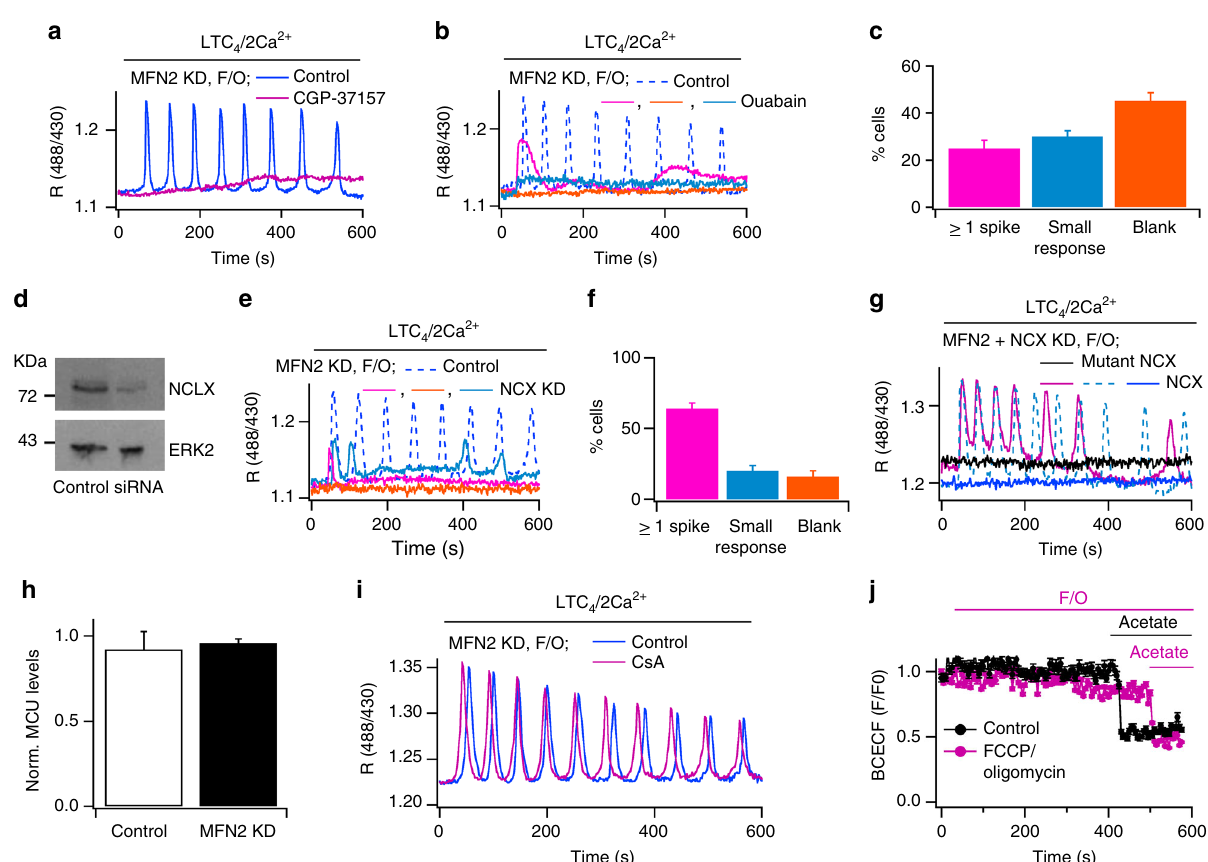
Fig. 2 Oscillations in matrix Ca 2+ by mitochondrial Na + – Ca 2+ exchange. In panels a – f , mitofusin 2 was knocked down and cells were pre-treated acutely with FCCP and oligomycin prior to LTC 4 challenge. Matrix Ca 2+ was measured with ratiometric pericam. a Pre-exposure (10 min) to CGP-37157 (10 μ M) abolished matrix Ca 2+ oscillations to LTC 4 (control: blue trace, typical of 21/29 cells; CGP-treated: red trace, typical of 12/12 cells). b As in panel a , but ouabain (25 μ M; 15 min pre-treatment) was used to raise cytosolic Na + . Three types of matrix Ca 2+ response to LTC 4 were now observed; blank/no response (orange), a small slow rise (blue) or at least one spike (magenta). c Bar plot shows the fractional responses, as in panel b . Total number of cells analysed was 24. d Western blot compares Na + – Ca 2+ exchanger expression in control cells and in cells after siRNA-directed knockdown. e Ca 2+ oscillations to LTC 4 are suppressed following Na + – Ca 2+ exchanger knockdown. Three types of response were now observed (see panel f ). f Bar plot shows the types of responses of matrix Ca 2+ to LTC 4 following exchanger knockdown (as described in panel c ). Total number of cells analysed was 20. g Matrix Ca 2+ oscillations to LTC 4 were induced in control cells but not in those expressing a catalytic mutant of the exchanger. Two types of response were seen when the wild type exchanger was overexpressed: no response (9/20 cells) and oscillatory responses (11/20 cells). The two oscillatory responses (dashed blue and magenta traces) depict the two patterns of oscillatory response. h Histogram compares MCU expression before and after mitofusin 2 had been knocked down. i Matrix Ca 2+ oscillations to LTC 4 are compared between a control cell and one pre-exposed (15 min) to cyclosporine A. In this experiment, mitofusin 2 was knocked down and FCCP/oligomycin applied 8 min before stimulation. j Cytosolic pH, measured with BCECF, is compared for control cells (black trace) and cells acutely exposed to FCCP/oligomycin (as indicated; red trace). Acetate was applied at the end of the experiment to induce cytosolic acidi fi cation. Each trace is the mean of between 16 and 21 cells. Error bars denote